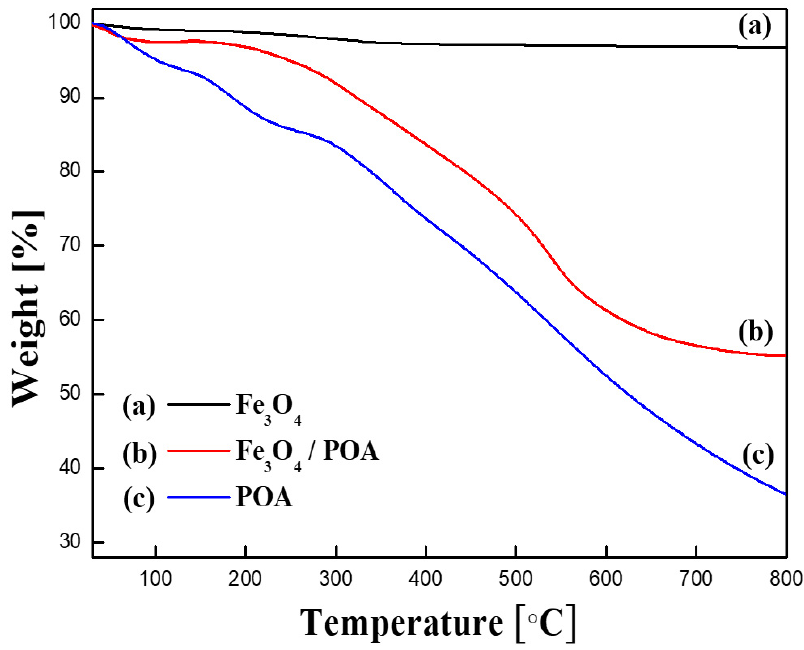
Figure 5. TGA diagram of the ( a ) pure Fe 3 O 4 , ( b ) Fe 3 O 4 /POA particles and ( c )